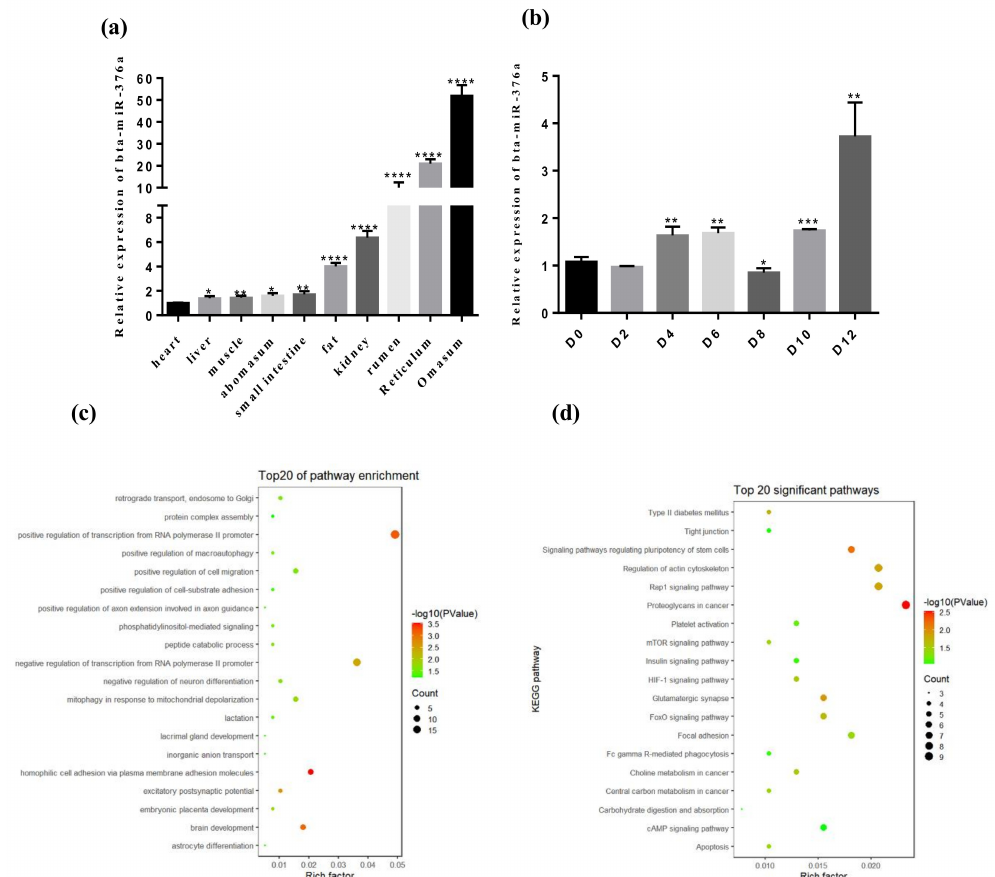
Figure 1. The specific changes of bta-miR-376a in tissue and time were observed. ( a ) Expression profile of bta-miR-376a in di ff erent tissues. ( b ) Expression of bta-miR-376a in bovine adipocytes at 0, 2, 4, 6, 8, 10, and 12 days of di ff erentiation. ( c ) Gene Ontology (GO) analysis of bta-miR-376a target gene predicted. ( d ) Analysis of Kyoto Encyclopedia of Genes and Genomes (KEGG) pathway of bta-miR-376a target genes predicted. The above results represent the mean ± standard error of the mean (SEM) of three replicates ( n = 3). * p ≤ 0.05, ** p ≤ 0.01, *** p ≤ 0.001, and **** p ≤